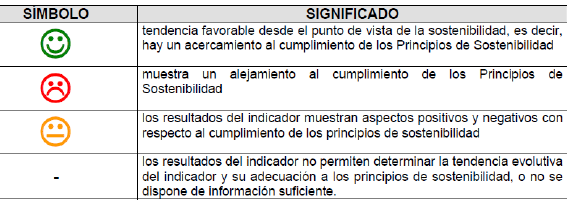
Figure 2- Pamplona uses coloured smiley face symbols in order to facilitate communication of benchmarking